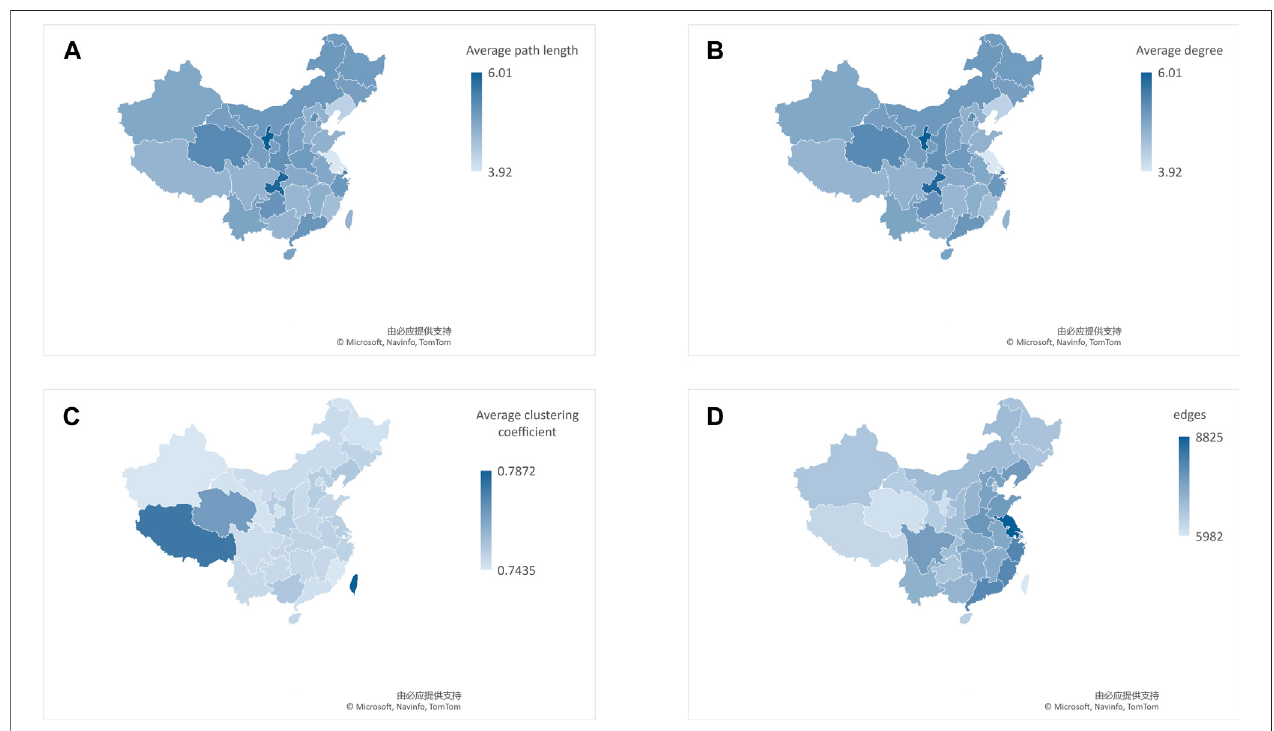
FIGURE 2 | Visibility network